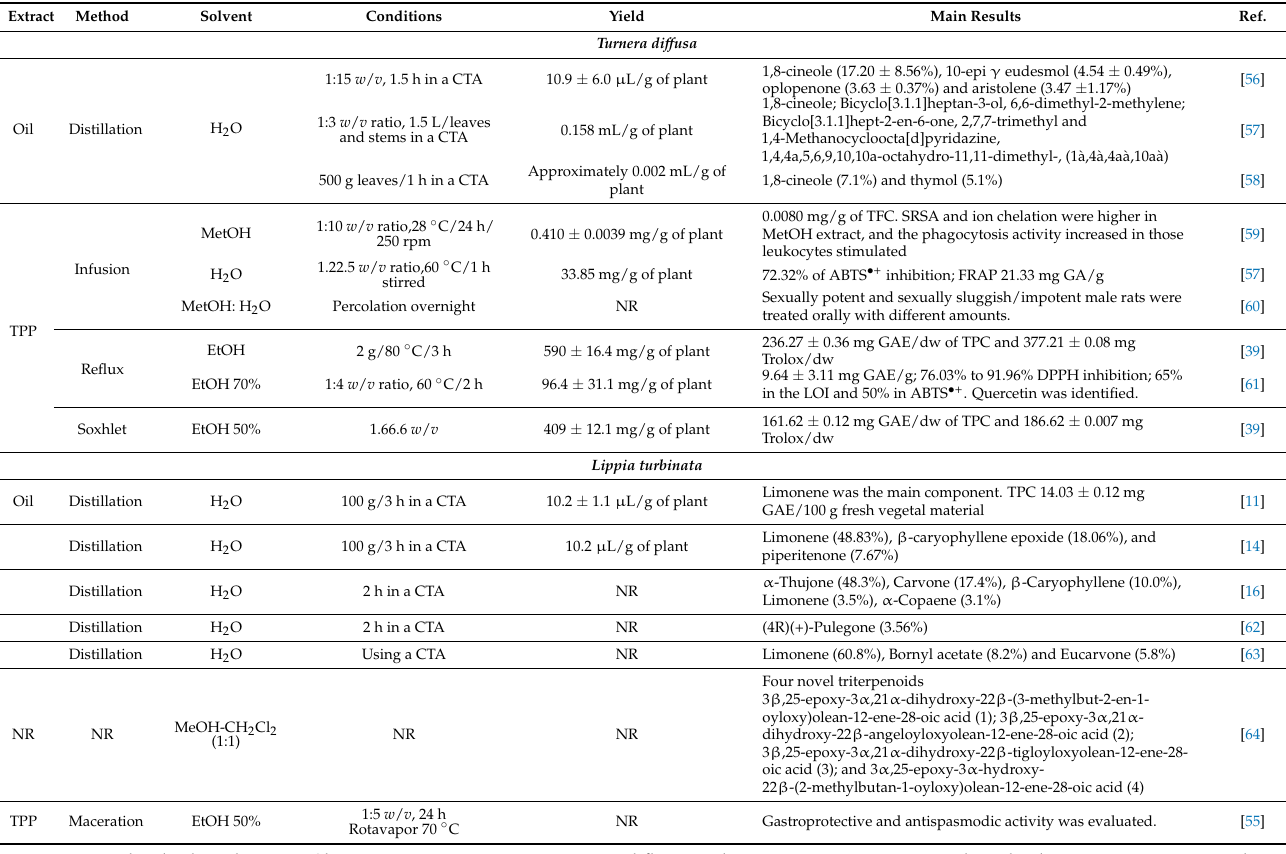
Table 1. Polyphenols and essential oils from Turnera diffusa and Lippia turbinata extracted for conventional methods. Extract Method MainResults Ref.